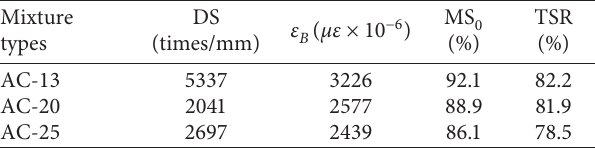
Table 7: Performance test results of different asphalt mixtures.